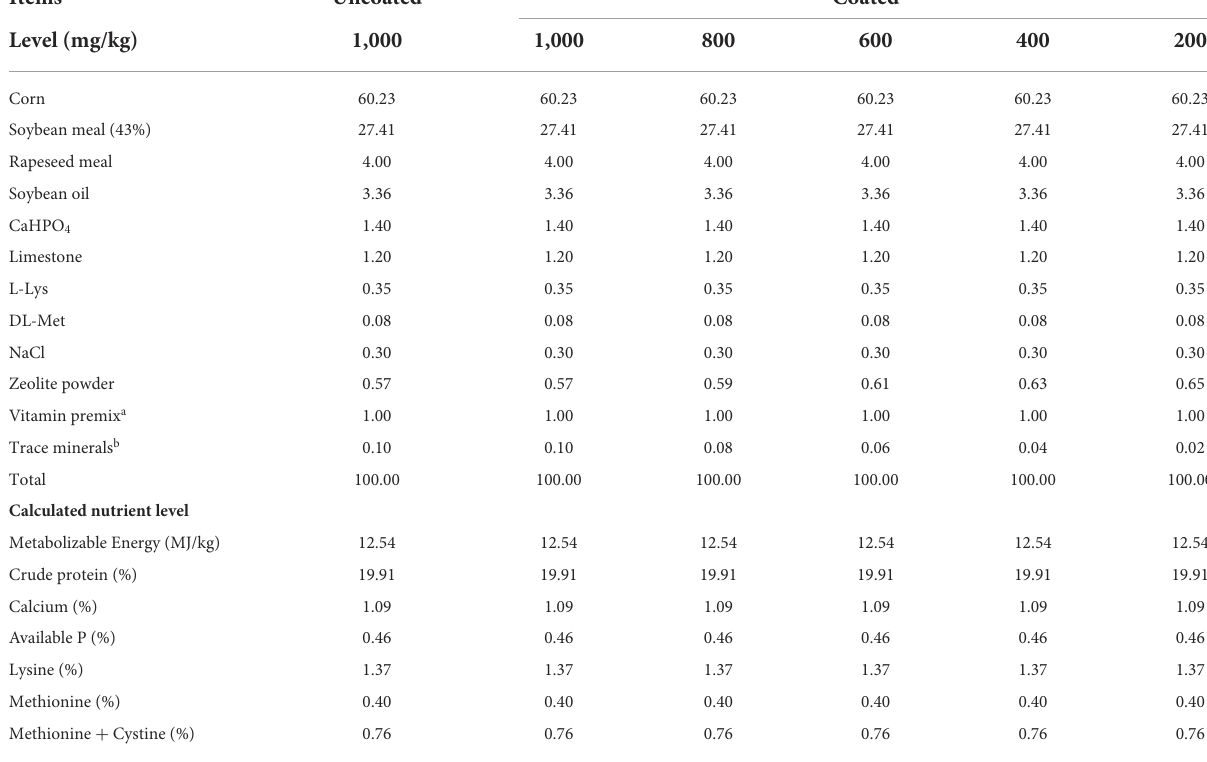
TABLE 3 Composition and nutrient levels of the diets for the grower period (29–56 days).